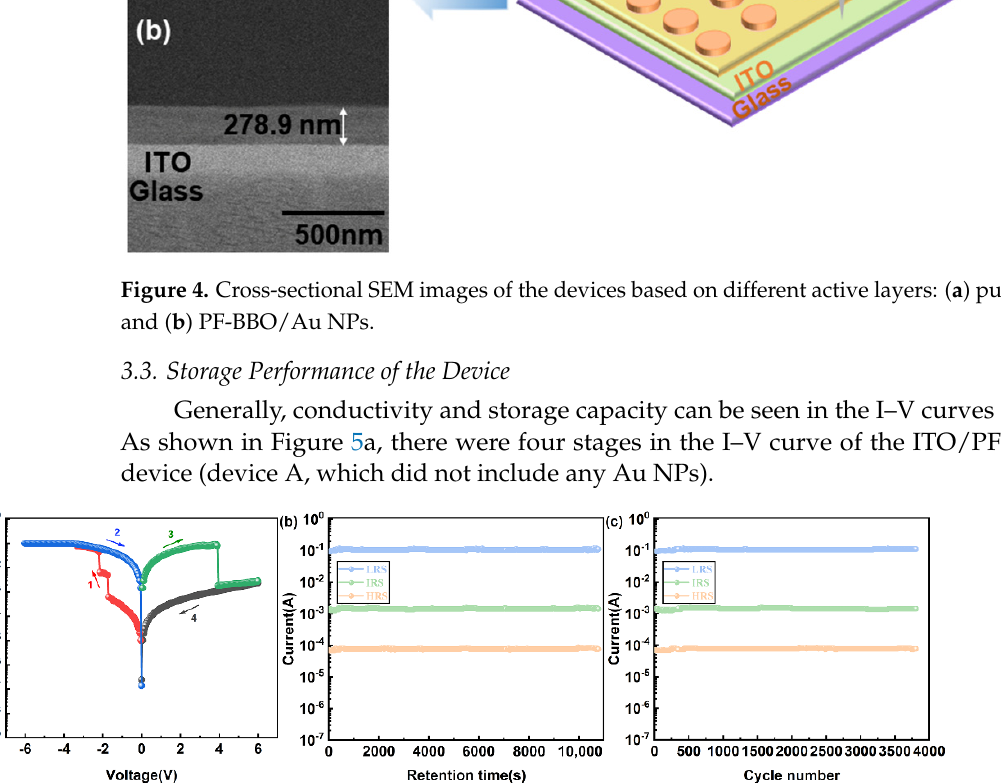
Figure 5. ( a ) The I–V curve, ( b ) retention time, and ( c ) cycle number of device